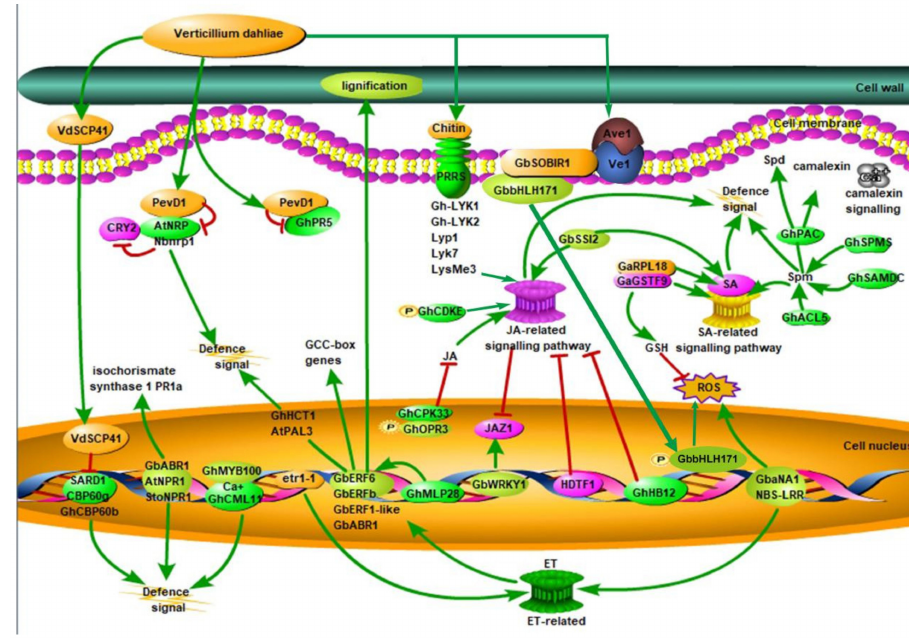
Figure 1. Regulation of intracellular signalling-related genes and signal transduction-related genes in response to Verticillium dahliae in plants. Plants have developed a sophisticated immune system to defend against V. dahliae . Plant cells immediately trigger signal transduction, leading to a rapid defence response including large-scale transcription reprogramming, while they recognise microbial-related molecular patterns or internal e ff ectors from V. dahliae .